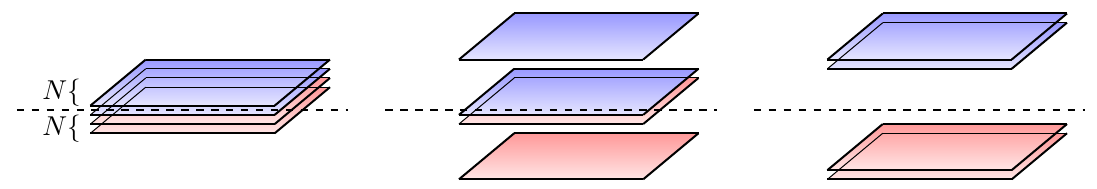
Figure 2 . Left: N D3 -branes probing an orientifold plane (dotted line), together with their mir- rors. Center: a configuration in which N − 1 branes probe the orientifold and one is pulled away; the positions of the internal stack span a C 3( N − 1) / W ( c N − 1 ) moduli space. Right: a configura- tion in which all N branes are pulled together away from the orientifold; their positions span a C 3 N / W ( a N − 1 ) moduli